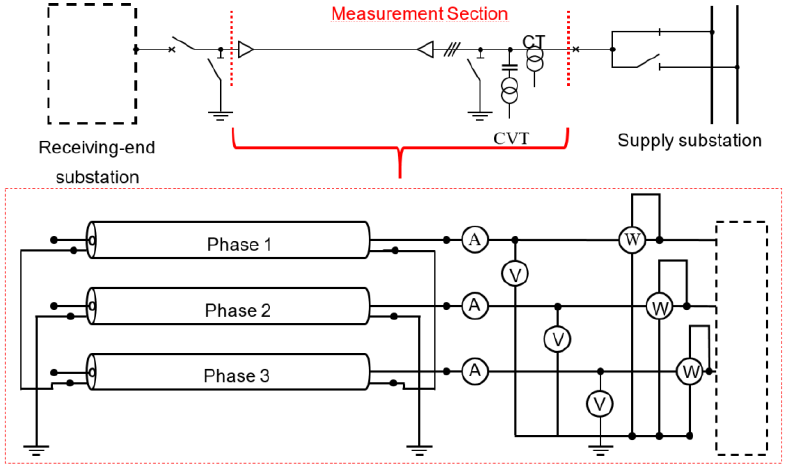
Figure 2. Equipment for measuring the shunt parameters. CT and A—current transformer; CVT and V—capacitor voltage transformer; W—wattmeter.